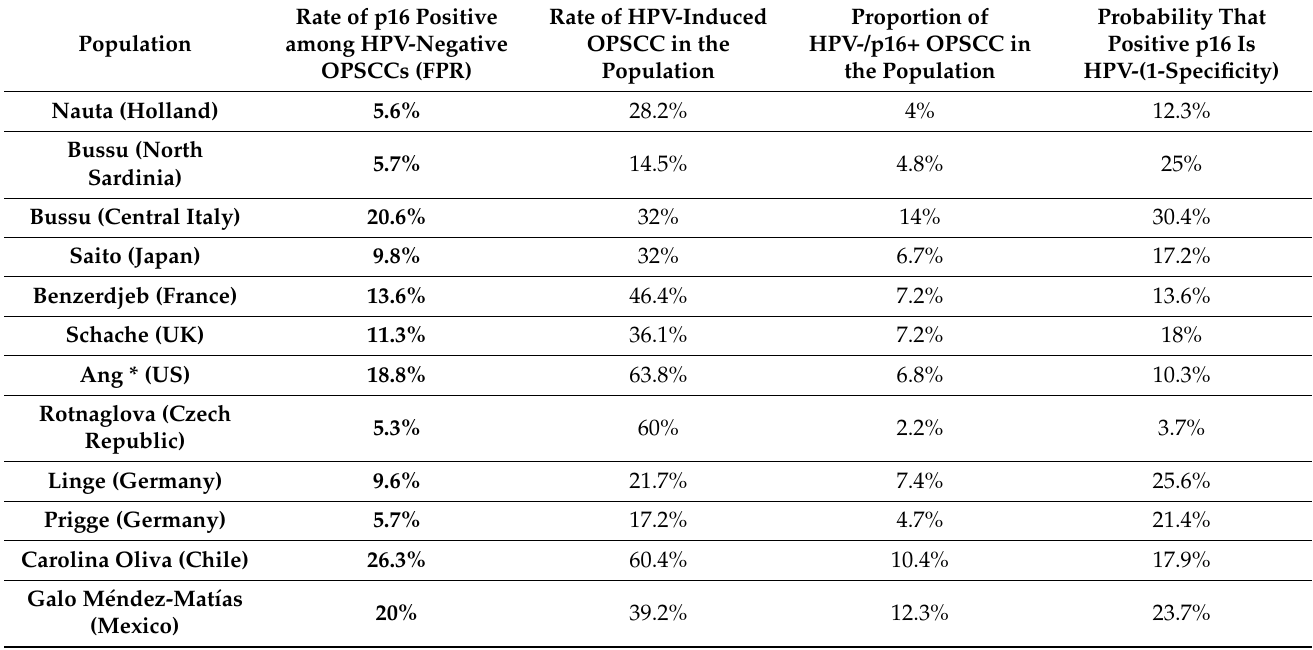
Table 2. Reliability of p16 IHC in different series of OPSCCs. Notably, the FPR is pretty constant for a certain assay even in very different populations (such as Dutch, Germans, Czechs, and Sardinians), while specificity decreases with the HPV-driven